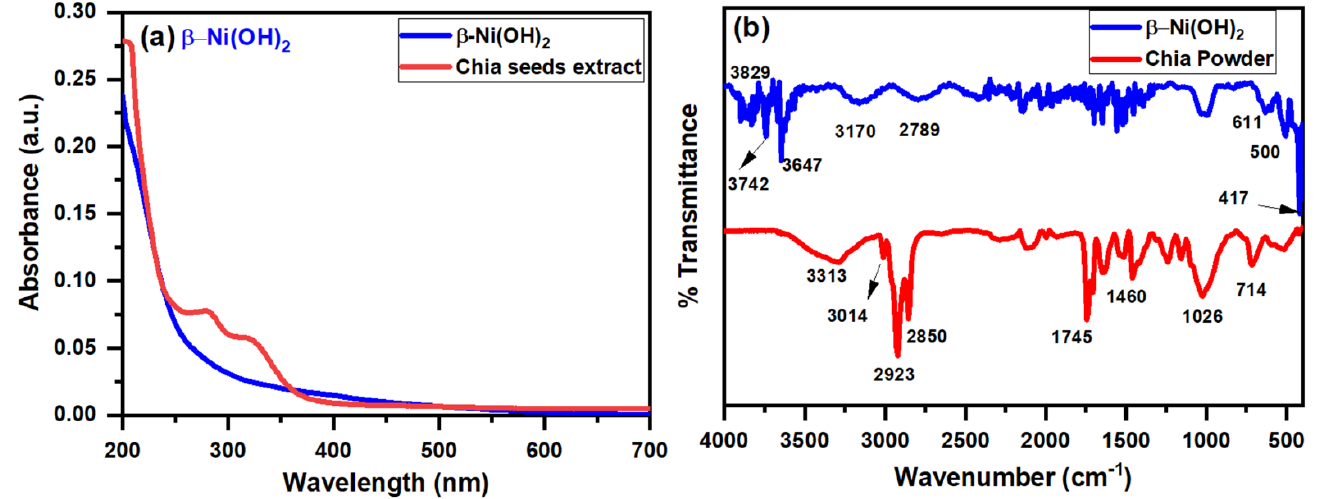
Figure 1. ( a ) UV-Vis spectra and ( b ) FT-IR spectra for chia powder and the biosynthesized β - Ni(OH)